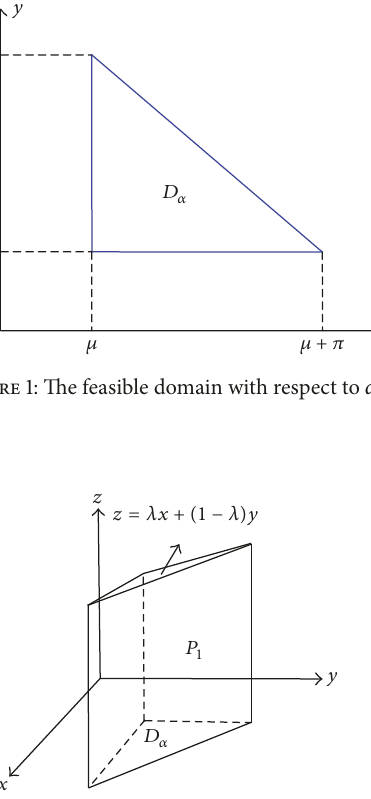
Figure 2: The graph of oblique triangular prism 𝑃 1